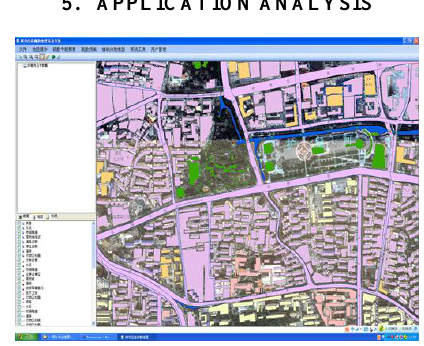
Figure 2 Urban emergency evacuation “one map”